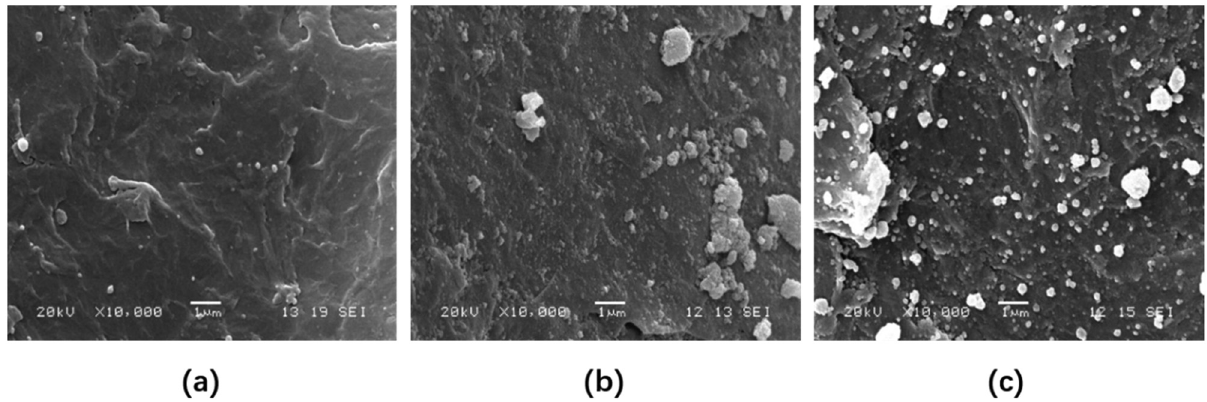
Figure 6: SEM photographs of the HA/PEEK powder with 2.5 wt% ( a ) , 10 wt% ( b ) , and 20 wt% ( c ) modi fi ed